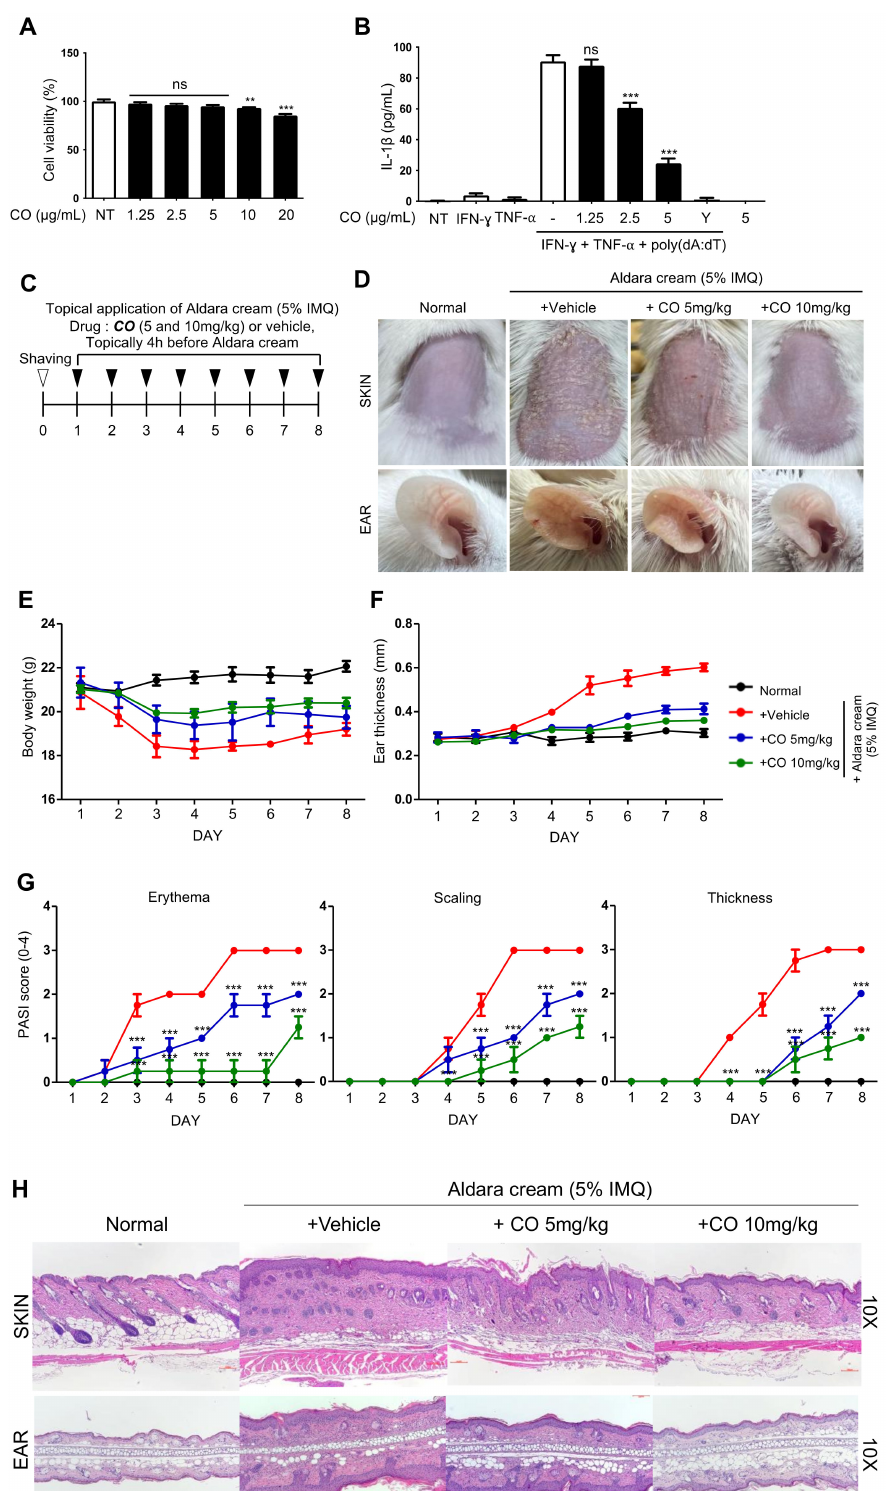
Figure 6. CO inhibits IMQ-induced skin pathology. ( A ) Cell viability of HaCaTs treated with the indicated concentrations of CO for 24 h measured by MTT assay. Data represent the means ± SDs of three independent experiments performed in triplicate; ** p < 0.01, *** p < 0.001, ns (non-significant) compared with the non-treated group. ( B ) IL-1 β concentrations in the culture supernatants of